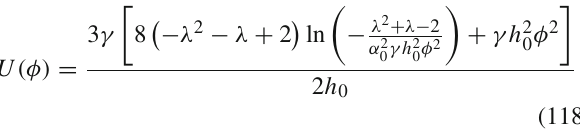
Fig. 2 The ratio of the temperature to the Hubble parameter during the inflationary evolution of the non-comoving warm inflationary model in the weak dissipation regime with power-law scale factors versus the number of e-folds, for different values of parameters of the model. During inflation the temperature is higher than the Hubble parameter, and their ratio decreases when approaching the end of